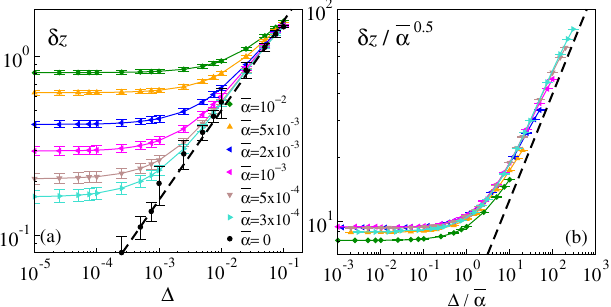
FIG. 2. (a) Log-log plot of δ z versus Δ for different values of ¯ α as indicated in legend. The black dashed line corresponds to ffiffiffiffi p δ z ∼ Δ . (b) All these curves collapse if the y axis is rescaled by 1 = ¯ α 0 . 5 and the x axis is rescaled by 1 = ¯ α . Bars indicate standard deviations.